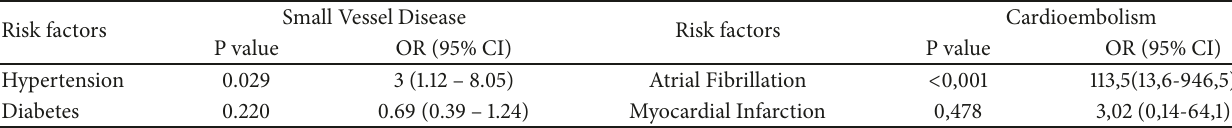
Table 3: Multivariate analysis in small vessel